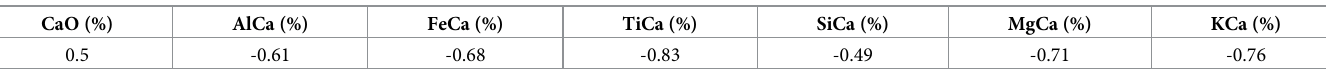
Table 3. Pearson’s correlation coefficients between soil pH and geochemical indices (p < 0.01).